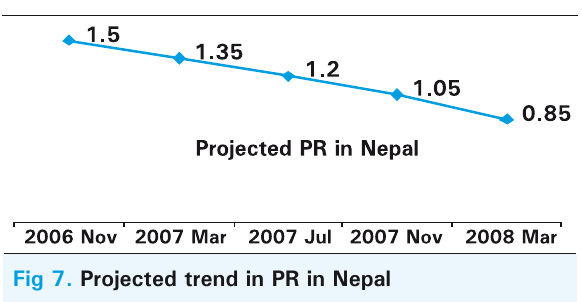
Fig 7. Projected trend in PR in Nepal The projections did not come true. Declining trend continued but at a reduced rate during the last year. in endemic districts due to